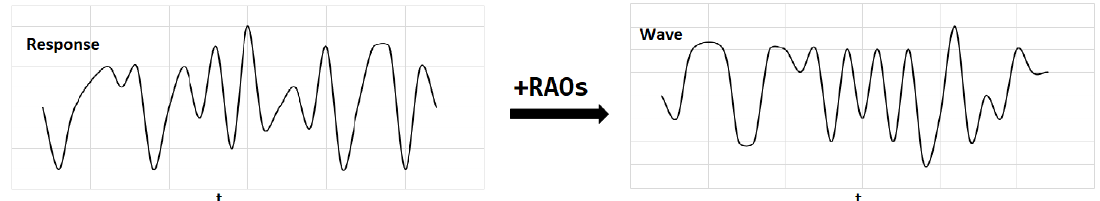
Figure 8. Illustration of the main idea of DWS estimation formulated in the time